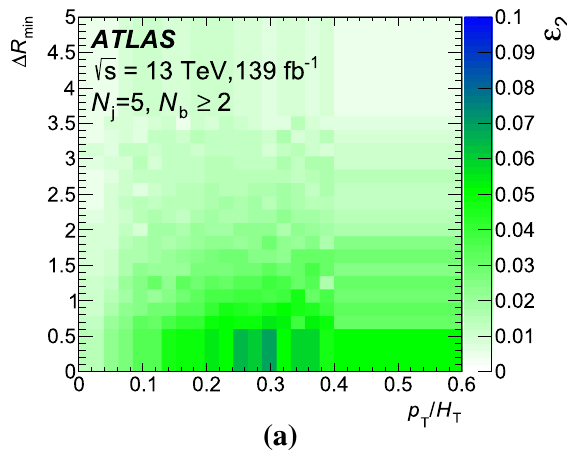
the a two or b three b -tagged jets with the highest b -tagging weight in the event, (cid:9) R min . The choice of binning is made so as to avoid empty